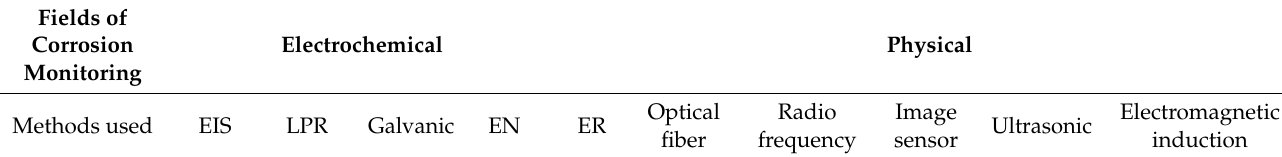
Table 3. Shows methods for the two main fields of electrochemical and physical